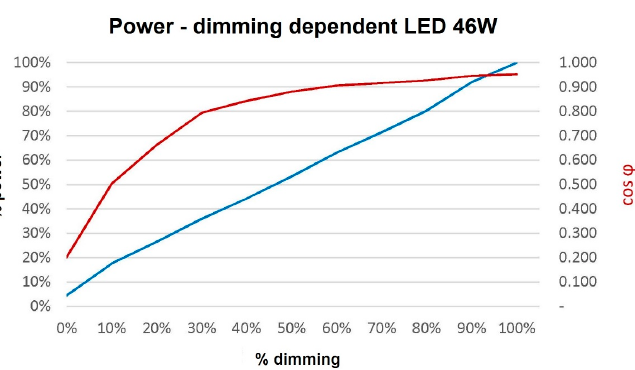
Figure 18. Power curve and cos ϕ depending on the dimming.